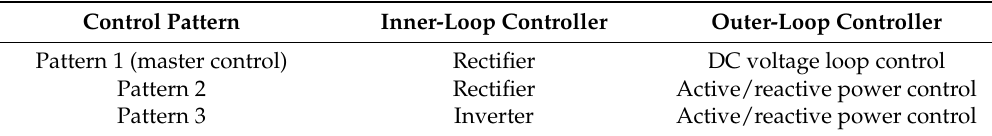
Table 1. Definition of the control patterns for VSCs under different operational conditions.